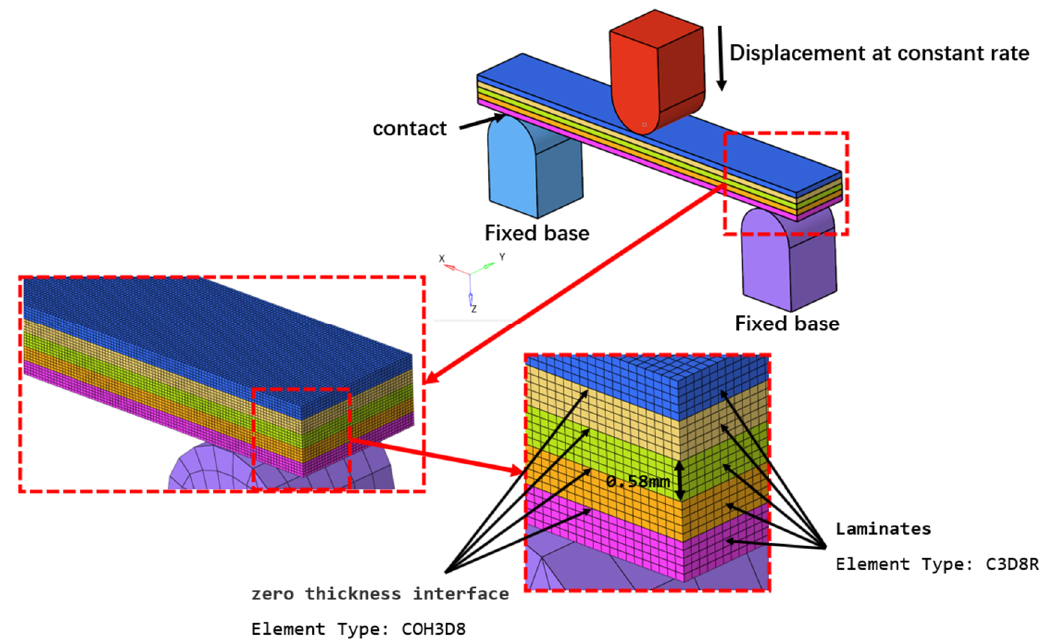
Figure 6. The 3D finite element model of three-point bending test for five-harness satin weave SiC f /PyC/SiC composite plates with five layers.